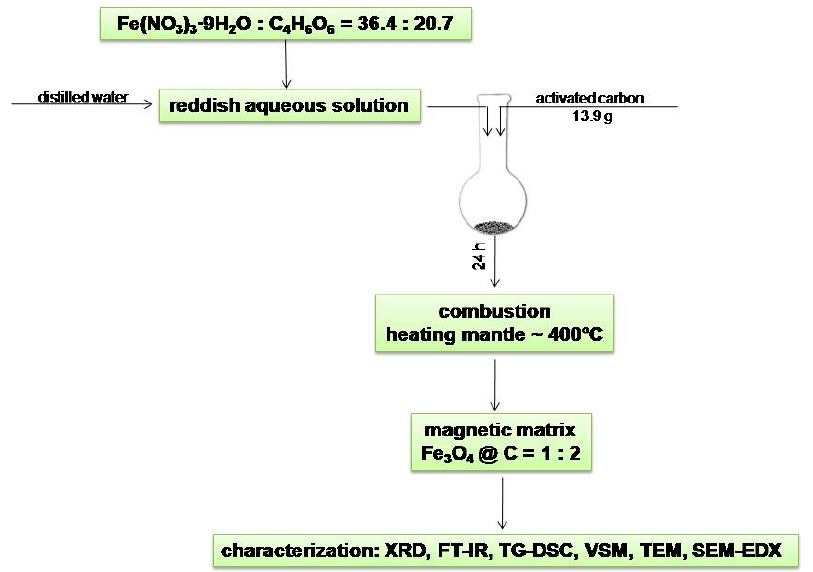
Figure 12. General preparation scheme of Fe 3 O 4 @C matrix.